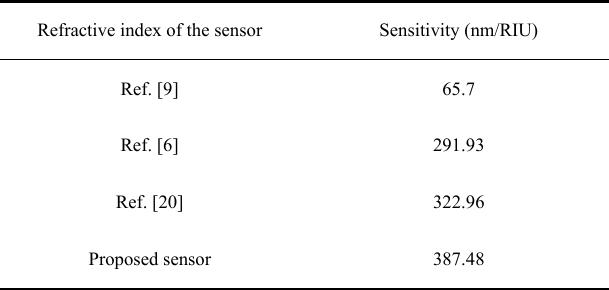
Fig. 4 Variation of the resonant wavelength for a change in the refractive index of the biomaterial. Table 1 Sensitivity comparison of various